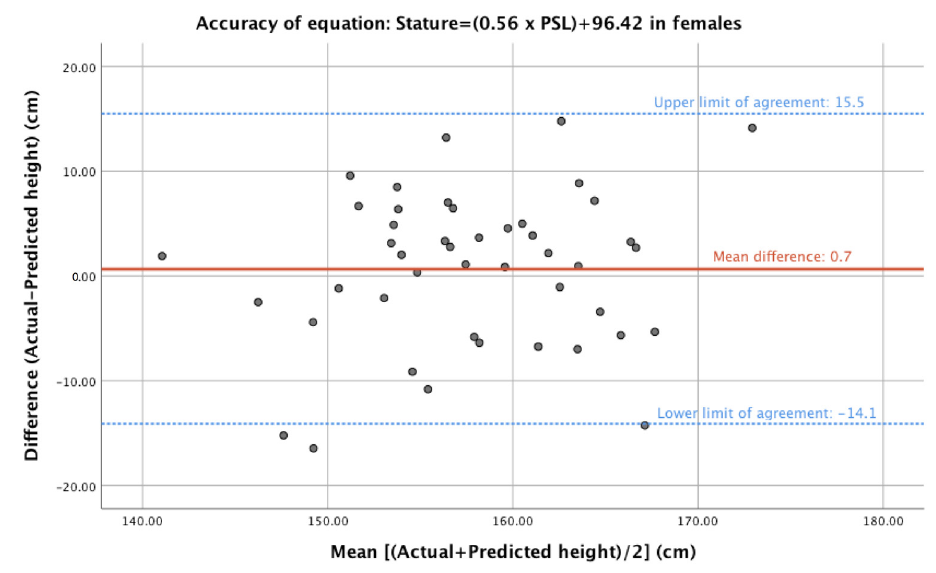
Figure 2. Bland–Altman plot of difference (actual—predicted height) and mean (of actual and pre-